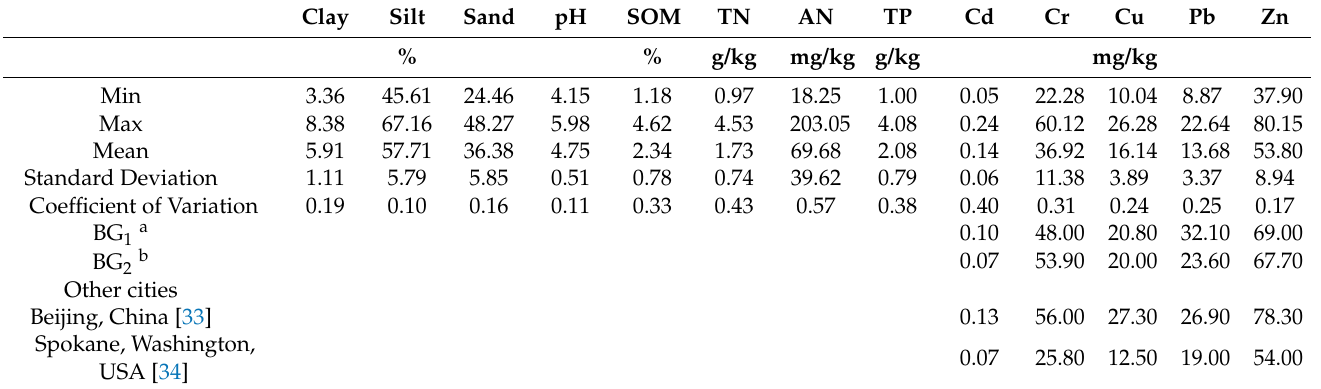
Table 5. The descriptive statistics of physicochemical properties in soil